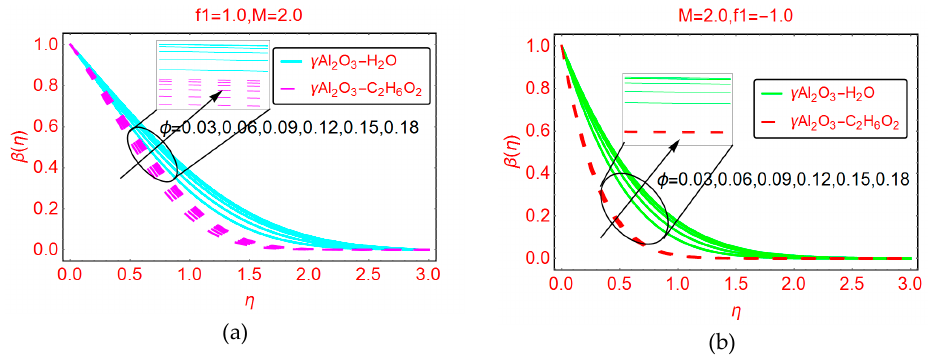
Figure 8. Effects of 𝜙 on the temperature profile 𝛽(𝜂) ( a ) 𝑓1 = 1.0 ( b ) 𝑓1 = −1.0